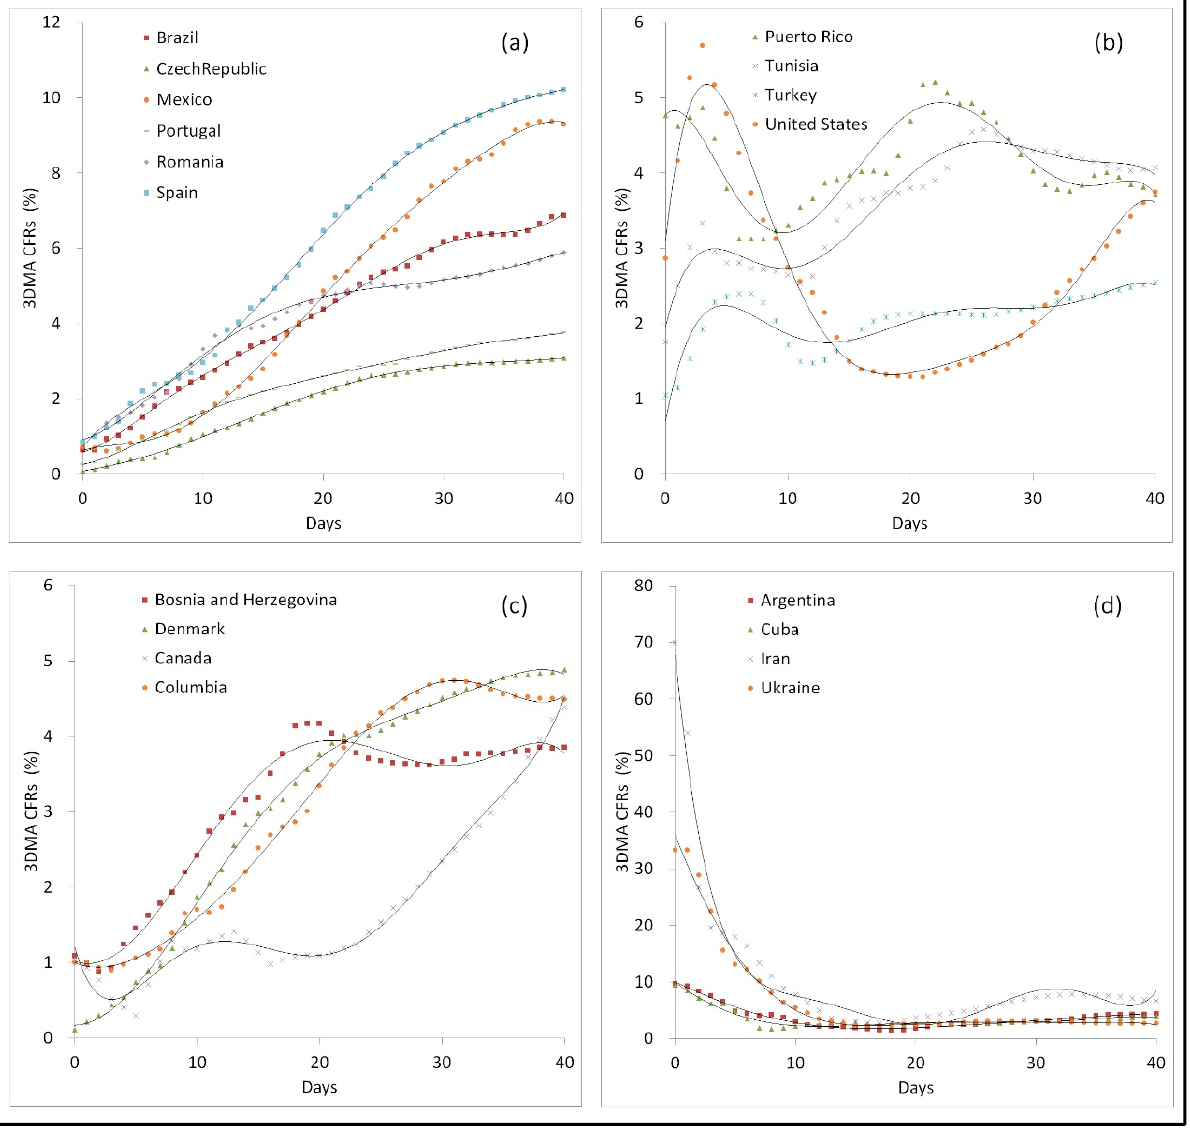
Figure 3. Representative national 3DMA-CFR curves for COVID-19 epidemics. ( a ) The arising curves without turning points. ( b ) The curves containing similar falling zones marked with the first high turning points and the second low turning points. ( c ) The curves showing the first falling and then the second rising based on the low turning points. ( d ) The curves showed the first falling and then the second massively rising based on the low turning points.